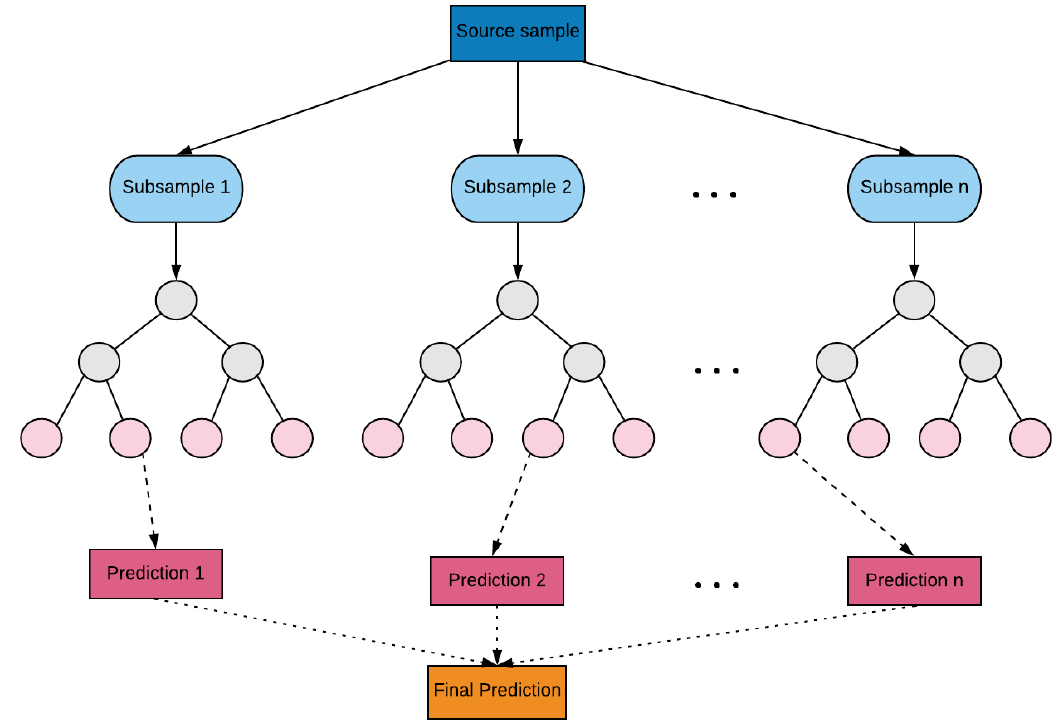
Figure 1. General structure of a random forest model. Source: adapted from [37] and prepared by the